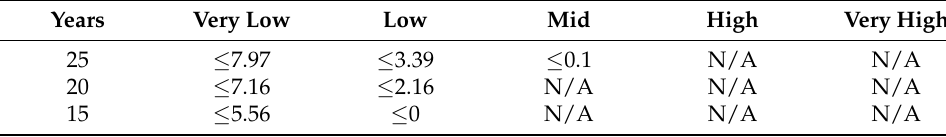
Table 14. BEIS Discount Rate Pure Case.